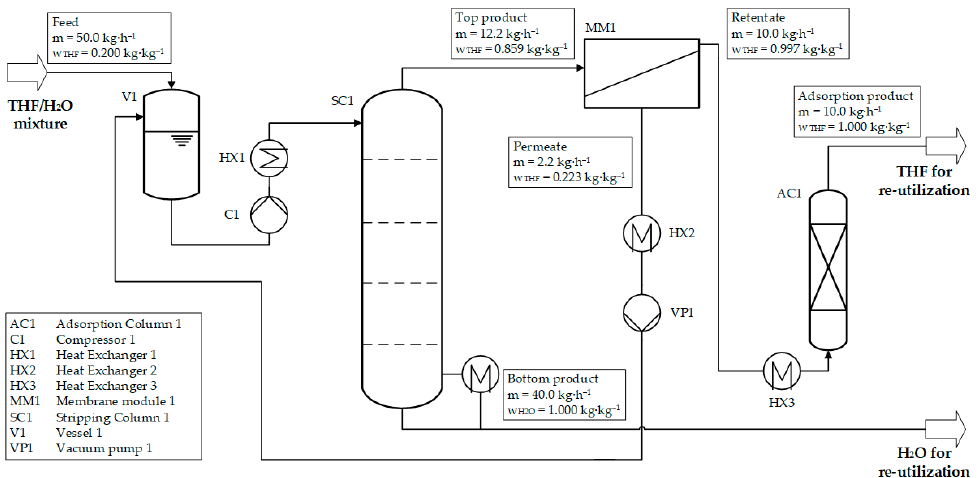
Processes 2021 , 9 , x FOR PEER REVIEW Figure 4. Process simulation in Aspen Plus Dynamics ® with all subprocesses in combination.